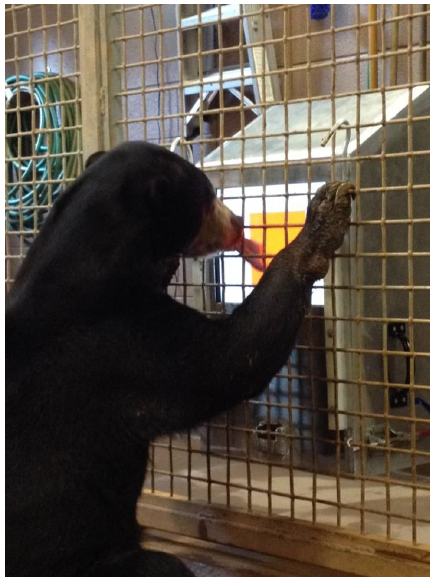
Figure 1. Sun bear interacting with touchscreen computer.